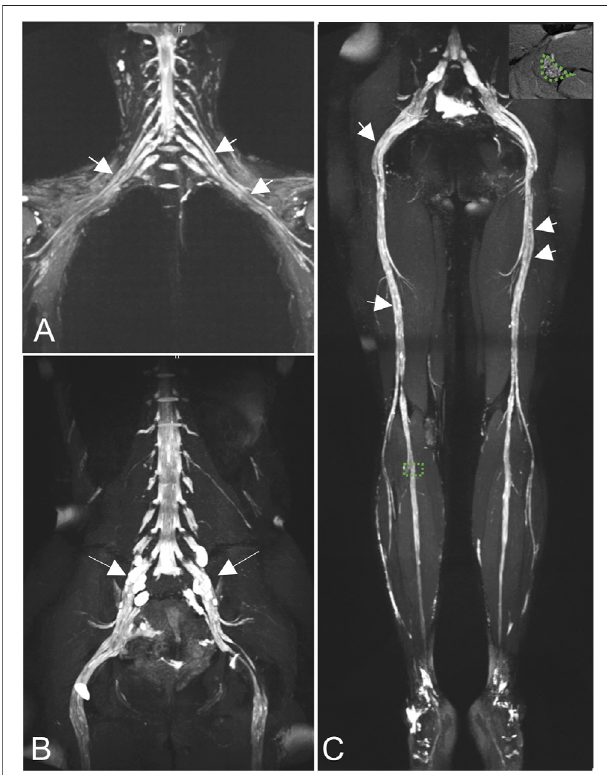
FIGURE 2 | Coronal magnetic resonance neurography (MRN) showed that diffuse uniform hypertrophy of the brachial plexus (A) and multifocal fusiform hypertrophy of the lumbosacral (LS) plexus [ (B) , long arrows)], with increased signal intensity. Neural stems exhibited worm-eaten signal reductions in the brachial, LS plexus, and sciatic nerves (short arrows). Magni fi ed views of areas of interest on the right peroneal nerve are shown in the right upper corners of the images